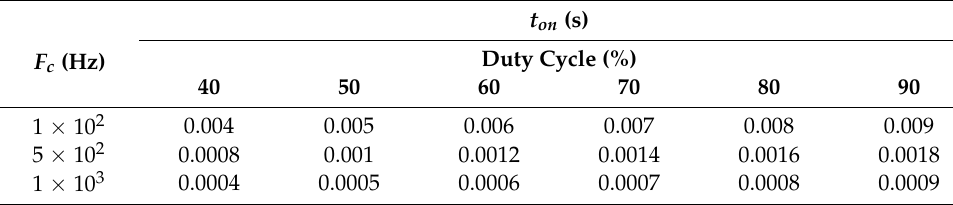
Table 3. Values of t on